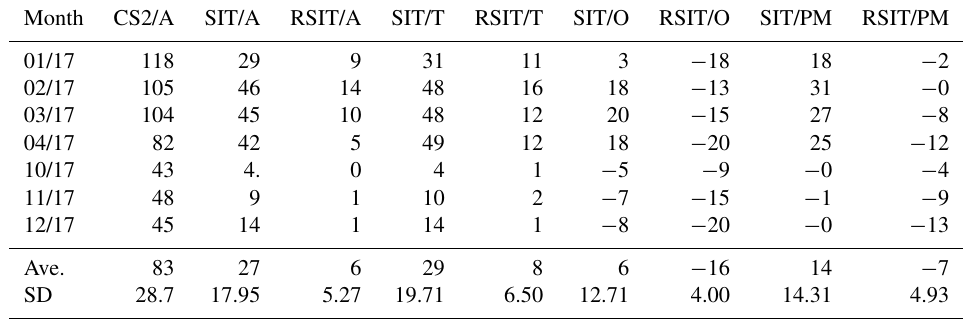
Table 2. Monthly average bias in centimetres between the different SIT estimates with respect to the SIT reference data sets. The symbols are the same as in Table 1.